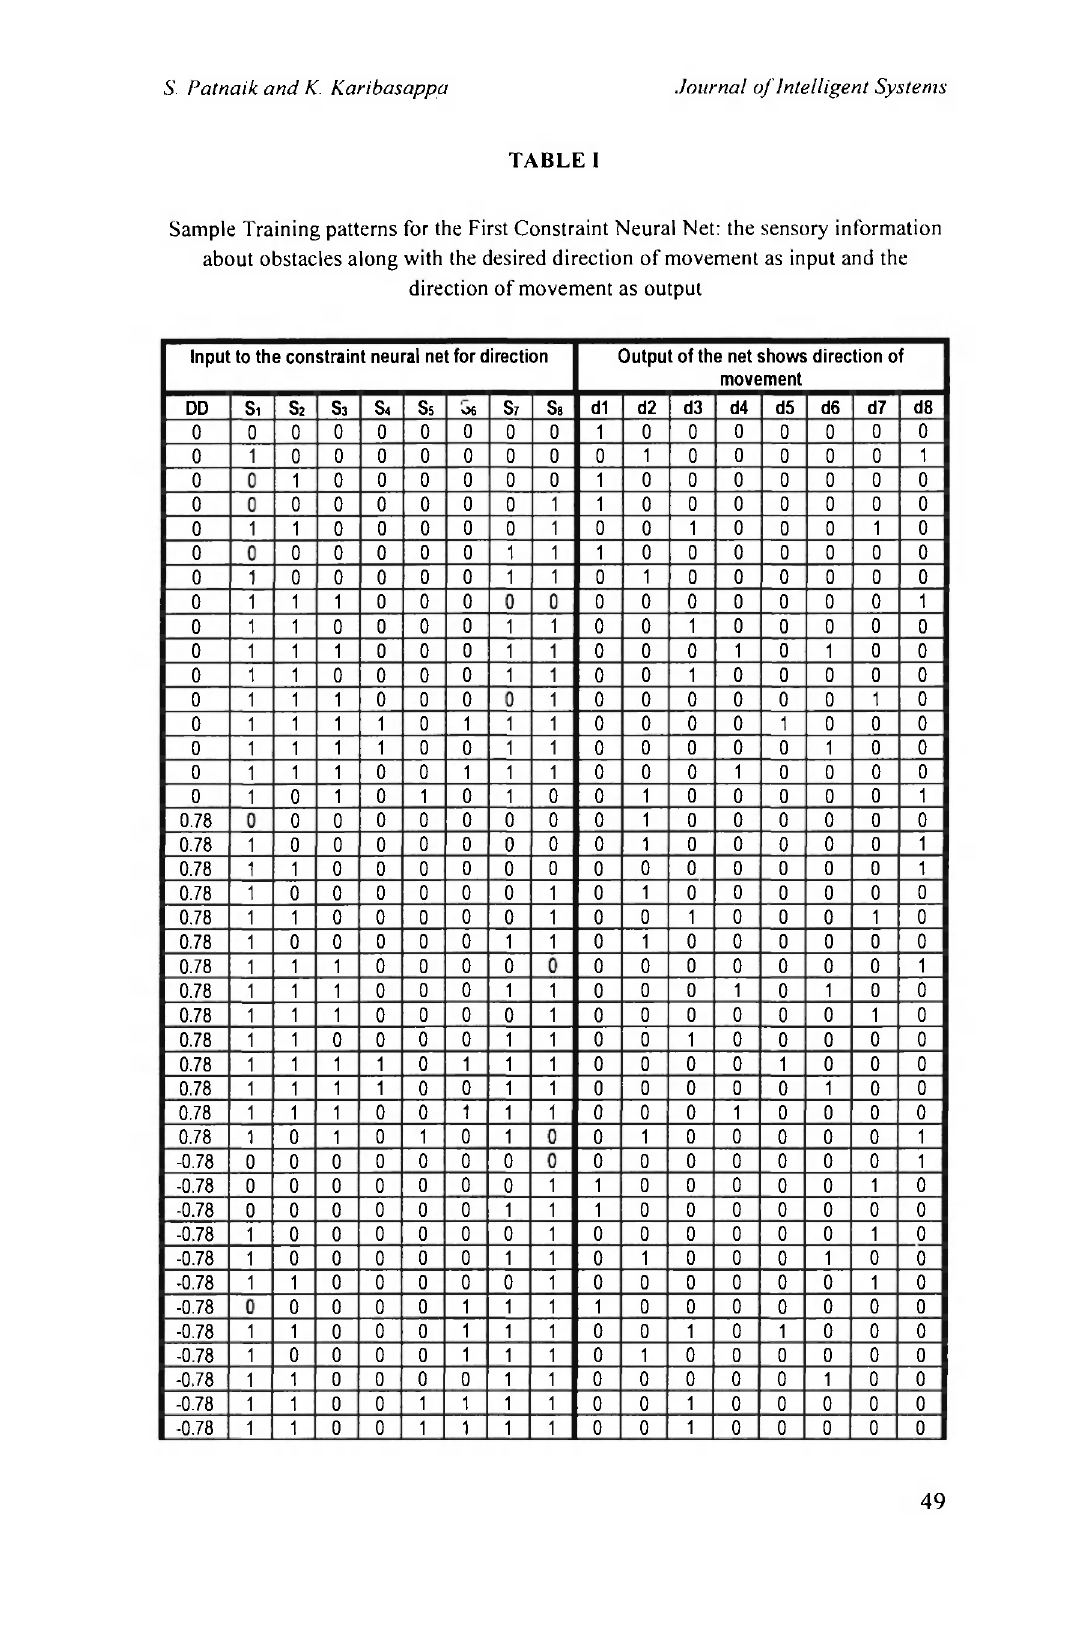
Sample Training patterns for the First Constraint Neural Net: the sensory information about obstacles along with the desired direction of movement as input and the direction of movement as output